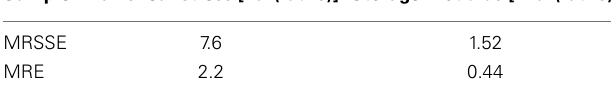
Table 6 | Change rate for storage modulus and maximum shear stress